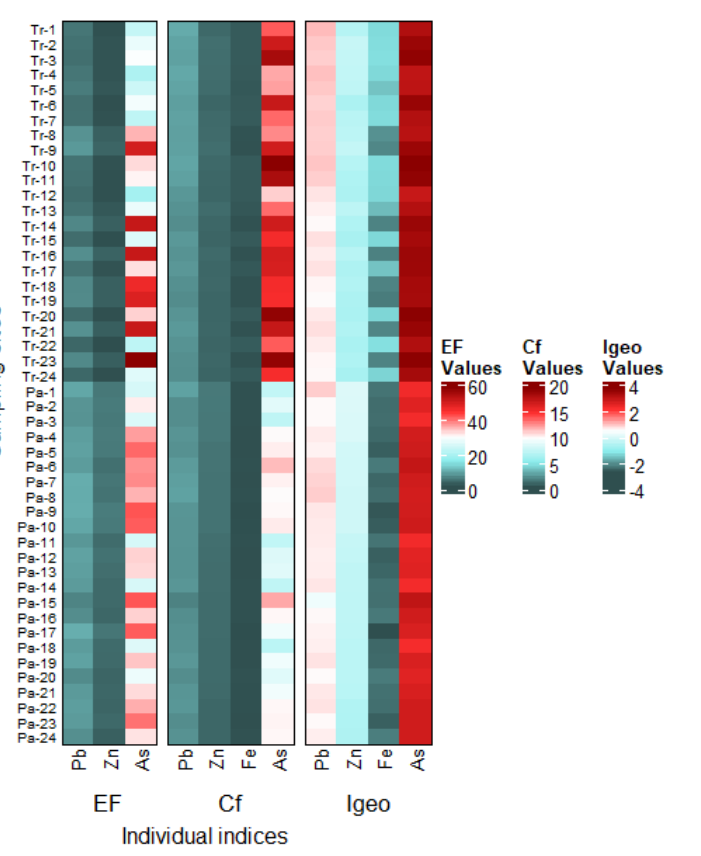
Figure 2. Contamination factor (Cf), enrichment factor (EF), and geoaccumulation index (I geo ) of heavy metals in the Paca (Pa) and Tragadero (Tr) lagoons.